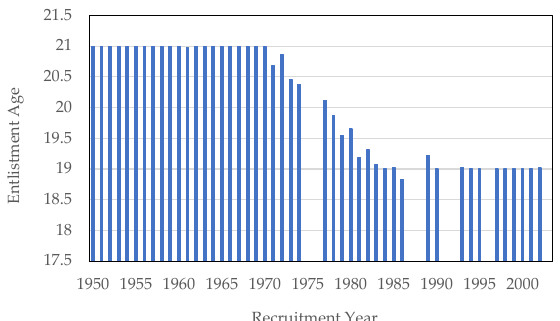
Figure 3. Changes in the recruitment regulatory age between 1969 and 1986. Source: AMSB, ACDS. Own work. The measurement system also changed and became simpler. The municipalities ceased to carry out their function of enlisting and classifying the recruits, whose control passed to the military recruitment centers ( Caja de Reclutas ) from the 1980s through the presentation of the National Identity Card. This system of quintas remained valid until December of 2001. There were also changes in the measurement of heights. Until 1969, height was measured in millimeters, and since then, it has been in centimeters. Equally,